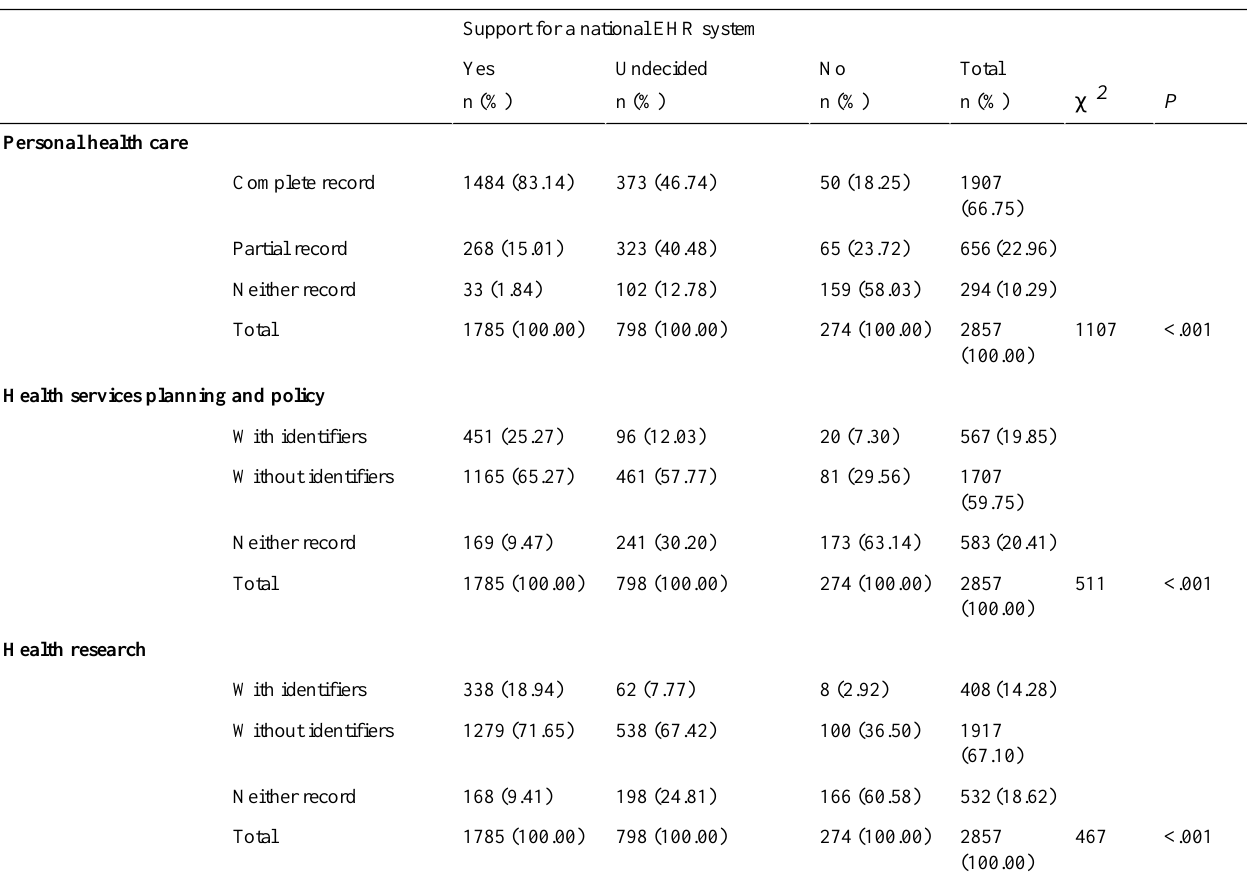
Table 2. Relationship between overall support for a national EHR system and views about the use of EHRs for personal health care, health services planning and policy, and health research, with Chi square ( χ 2 ) tests used to test for statistical significance